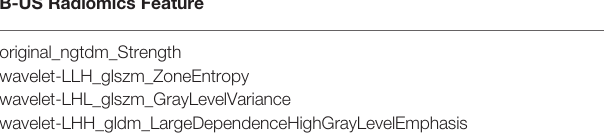
TABLE 2 | The B-US radiomics features.